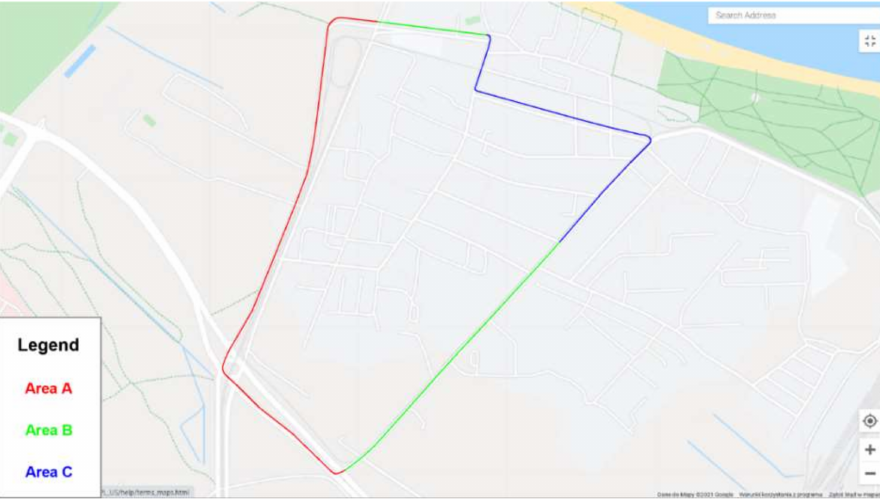
Figure 9. A plan of the test loop divided into different measurement